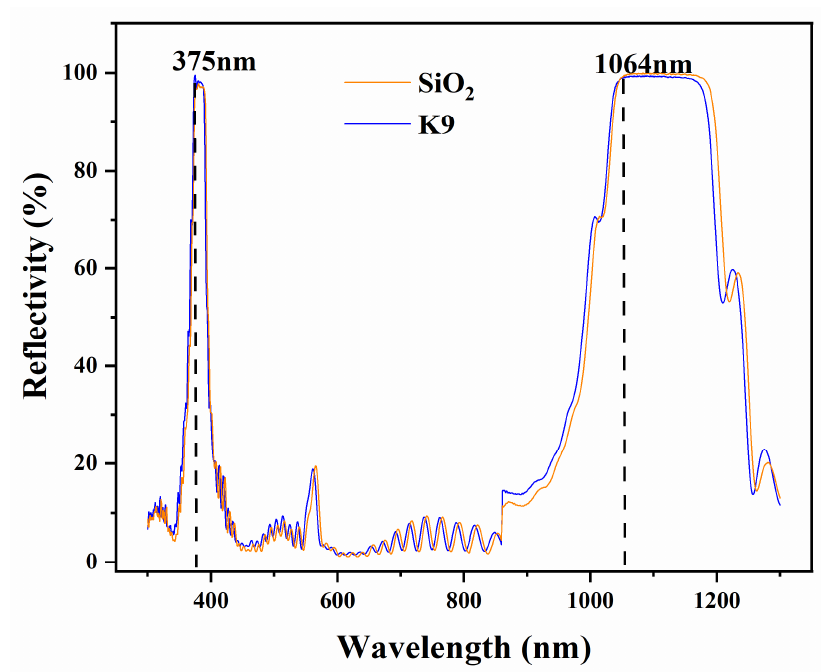
Figure 3. The spectra of high-reflectivity dielectric coatings based on SiO 2 and K9 (in a 50% humidity